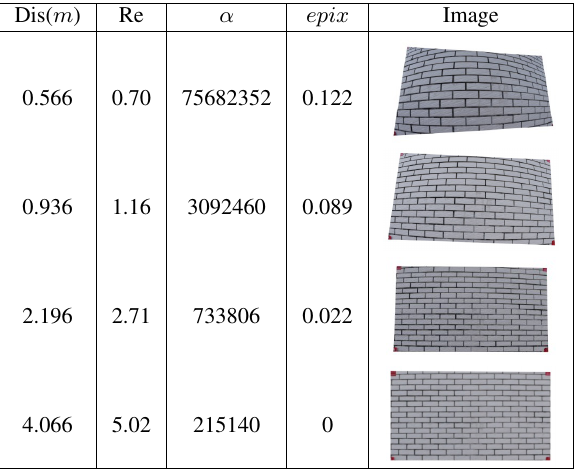
Through the change of the distance, the influence degree of the obstacle on the panoramic image is obtained, and the curve